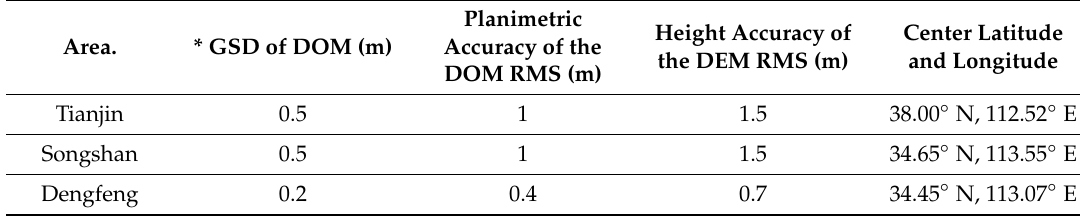
Table 3. Specific information about the reference data.